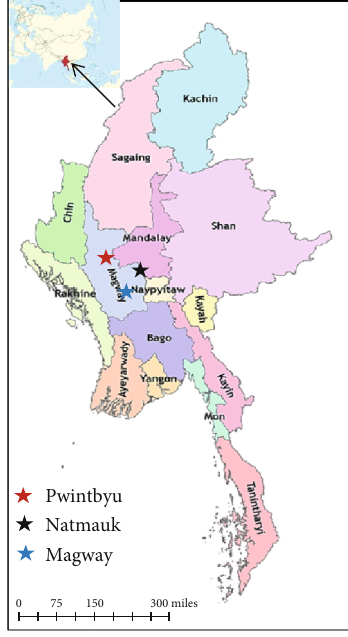
Figure 1: Location map of the study area. Table 1: Total number of samples collected from three